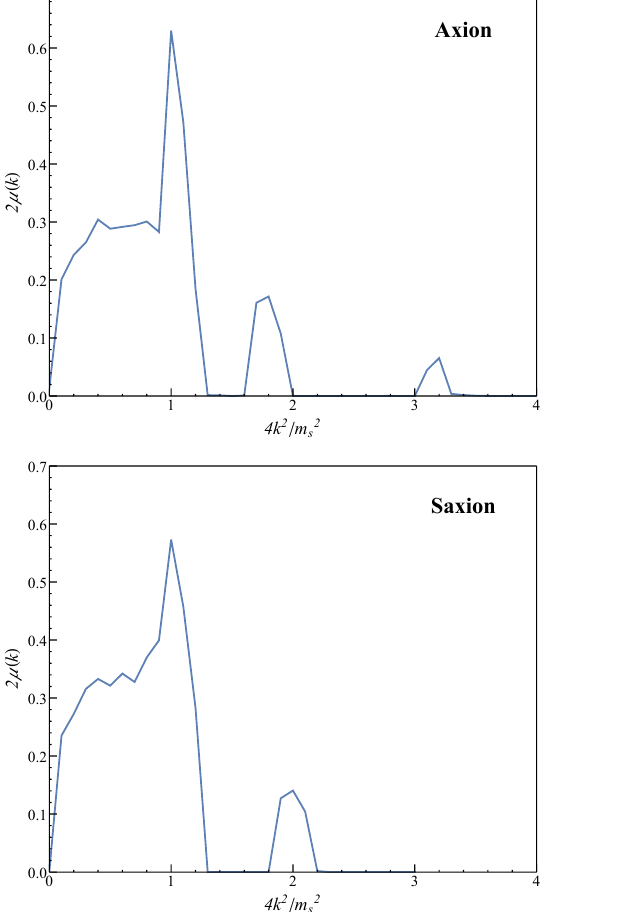
Figure 3 . Floquet indices for axion (top) and saxion (bottom) modes with a background saxion amplitude of 0.8 f a